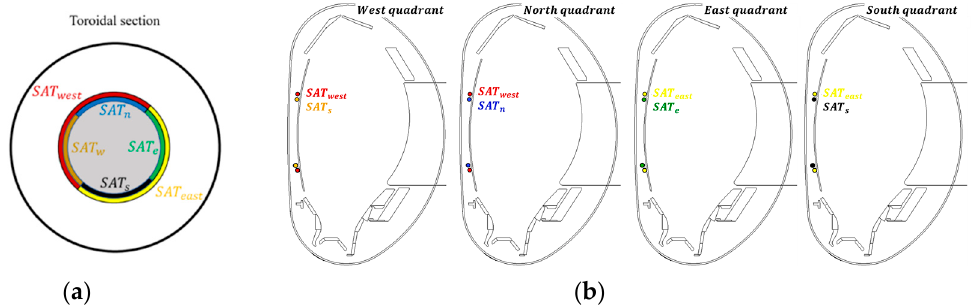
Figure 1. ( a ) Top view sketch of the actual arrangements of the two saddle coil systems measuring the radial field component of the magnetic field on the high field side (HFS) of axially symmetric divertor experiment—upgrade (AUG) [7]. A system composed by two saddle coils (SATwest and SATeast) has been upgraded in 2011 [7] adding four coils (Satn, Satw, Sate, Satw). ( b ) Poloidal cross sections with the coils location.